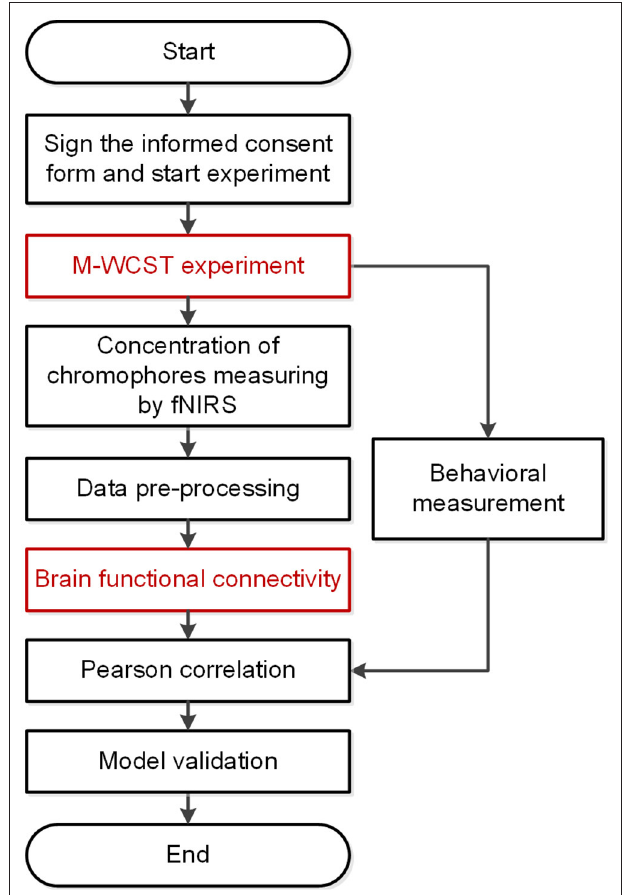
FIGURE 1 | Flowchart of the functional brain network analysis of knowledge